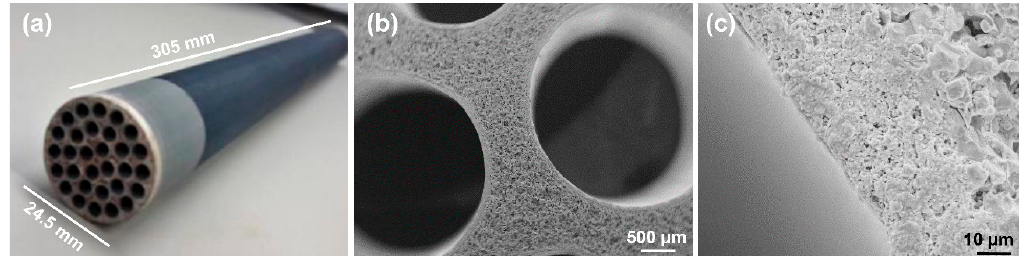
Figure 7. Silicon carbide tube (nominal pore size 0.04 µm) used for preparing the super-hydrophobic MD membrane SiC-fob ( a ) and SEM magnification of its channels ( b ) and multi-layer structure ( c ).